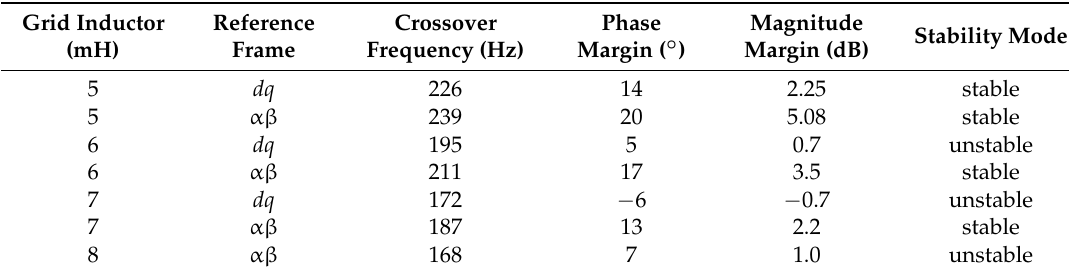
Table 3. Stability referring to different current reference